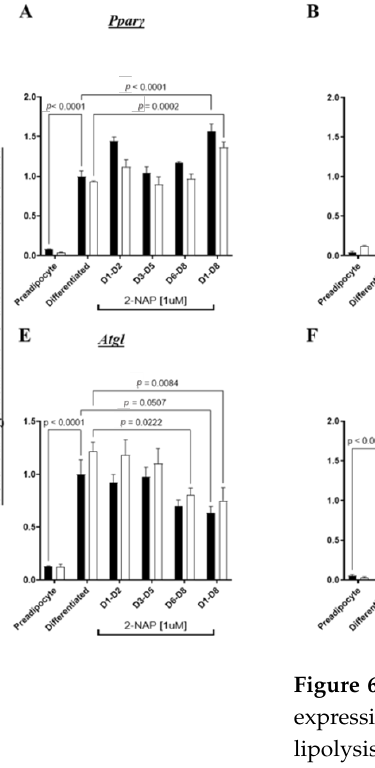
Figure 6. Effect of 2-NAP on thermogenic and adipogenic genes in BAT1 cells. Relative mRNA ex- pression of adipogenic transcription factors ( A ) P parγ and ( B ) C ebpα ; markers of lipogenesis and lipolysis ( C ) Fasn ; ( D ) Hsl , and ( E ) Atgl ; the adipokine ( F ) Adipoq ; and thermogenic genes ( G ) Ucp1 and ( H ) P gc1α was measured in BAT1 brown adipocytes chronically treated with 1 µM 2-NAP